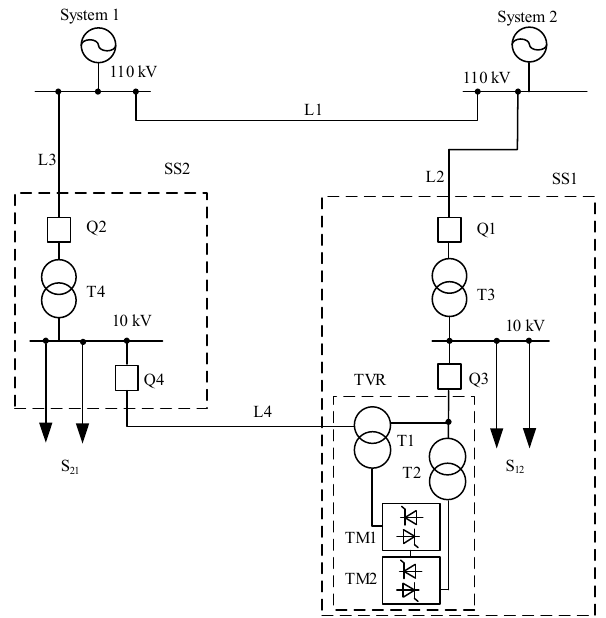
Figure 1. Single-line diagram of a distribution network with a TVR: L1—110 kV overhead line (70/11,